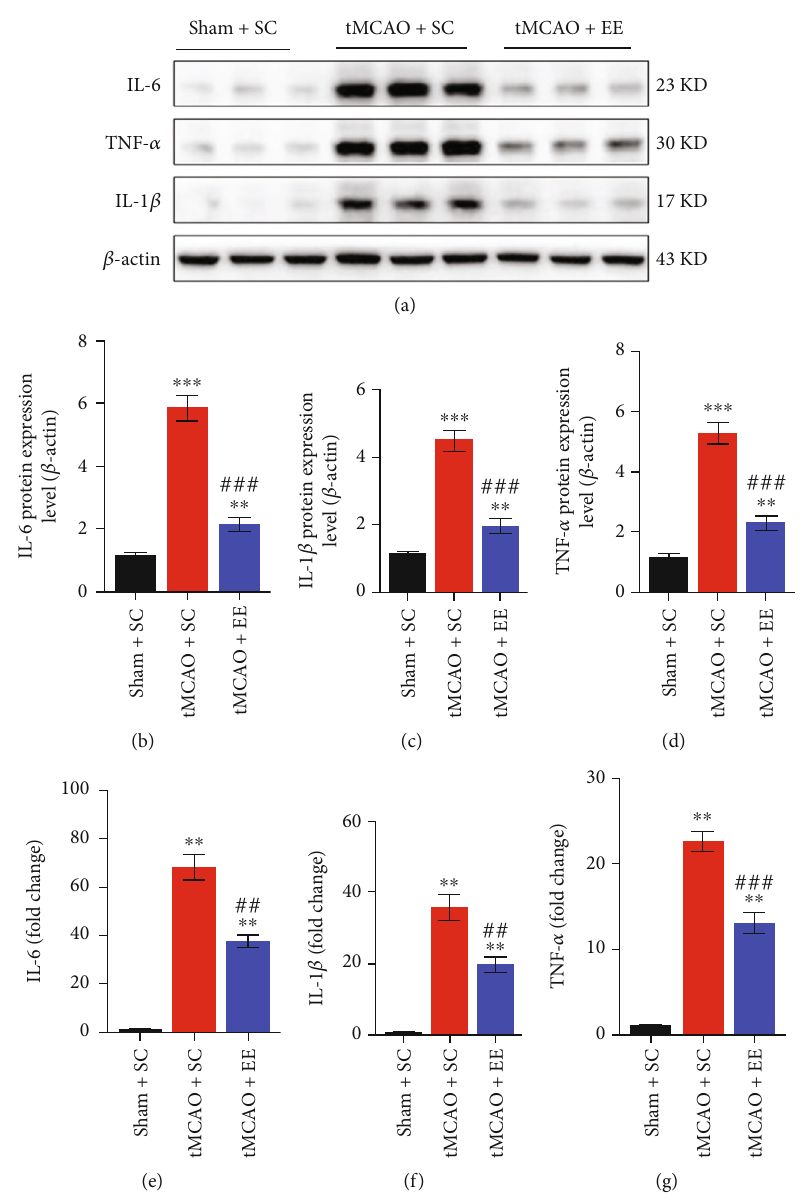
Figure 3: (a) Representative total protein Western blot images for in fl ammation. (b) Comparison of the β -actin-normalized IL-6 level between groups. (c) Comparison of the β -actin-normalized IL-1 β protein level between groups. (d) Comparison of the β -actin- normalized TNF- α protein level between groups. (e – g) qPCR results. (e) Comparison of the changes in the IL-6 level between groups. (f) Comparison of changes in IL-1 β levels between groups. (g) Comparison of changes in the TNF- α level between groups. ∗∗ P < 0 : 01 and ∗∗∗ P < 0 : 001 vs . sham+SC group; # P < 0 : 05 , ## P < 0 : 01 , and ### P < 0 : 001 vs . tMCAO+SC